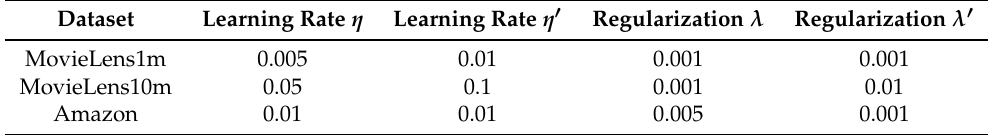
Table 2. Best performing hyper-parameters on the three datasets.